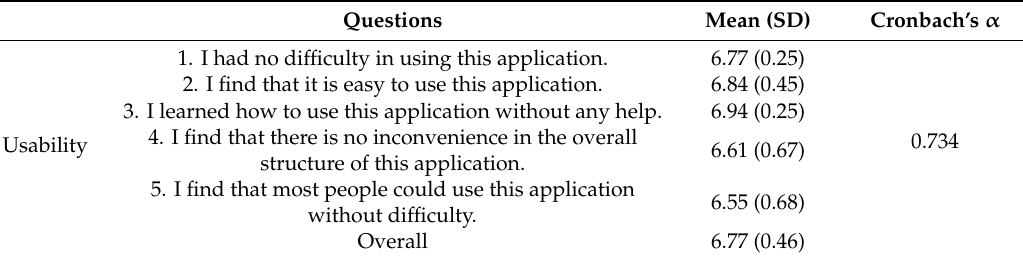
Table 3. Perceived usefulness of TeaPick TM